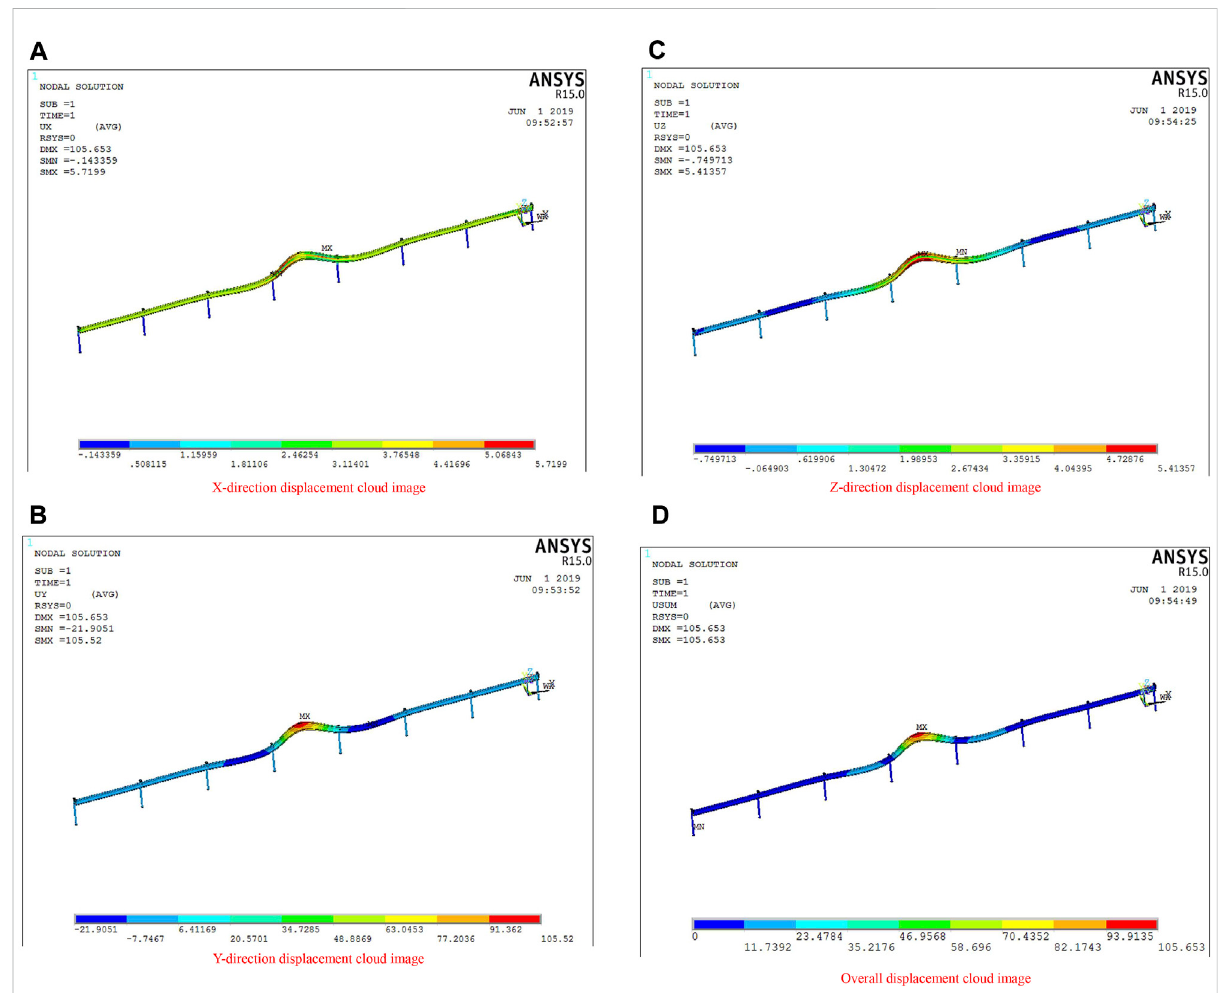
FIGURE 5 Displacementclouddiagramofathree-wavebeamsteelguardrail(impactedbythe1.5-tminibusatthespeedof100 km/hfromanangleof20 ° , the concrete-embedded post). (A) :X-direction displacement cloud image of three-wave beam steel guardrail; (B) :Y-direction displacement cloud image of three-wave beam steel guardrail; (C) :Z-direction displacement cloud image of three-wave beam steel guardrail; (D) : Overall displacement cloud diagram of three-wave beam steel